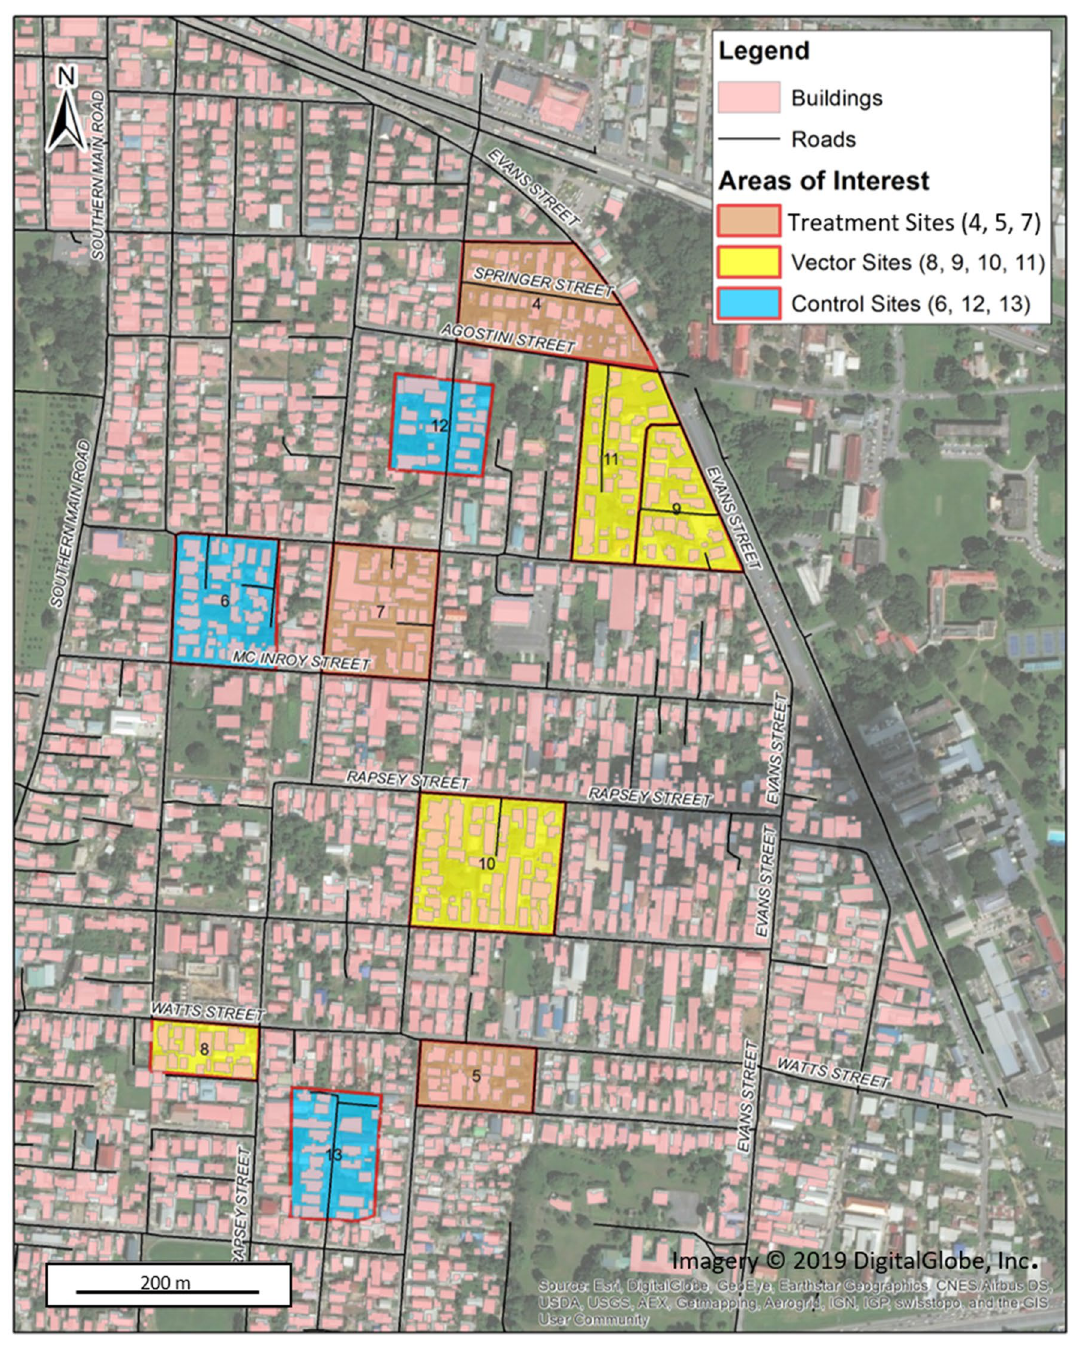
Figure 1. Map of study area in Curepe, Trinidad, West Indies from July to December 2019. Block areas identifying sites for Control, Vector, and Treatment yeast-baited 10 L ovitrap placement are highlighted. Figure was prepared with Environmental Systems Research Institute (ESRI). "Topographic basemap.” "World Topographic Map." (Sept. 28, 2021). https:// www. arcgis. com/ home/ item. html? id= 10df2 279f9 684e4 a9f6a 7f08f ebac2 a9. (May 21,